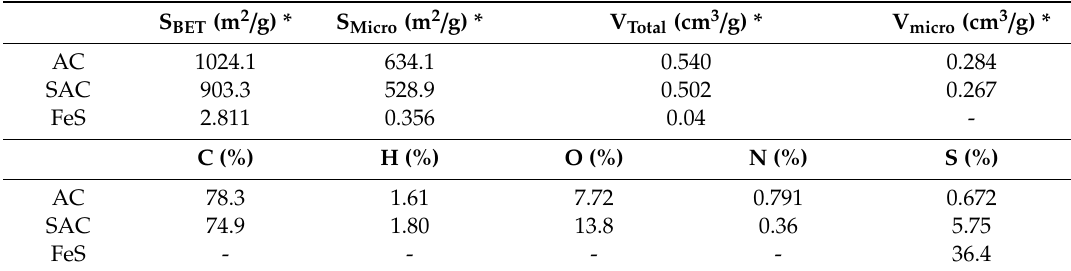
Table 1. The physicochemical properties of